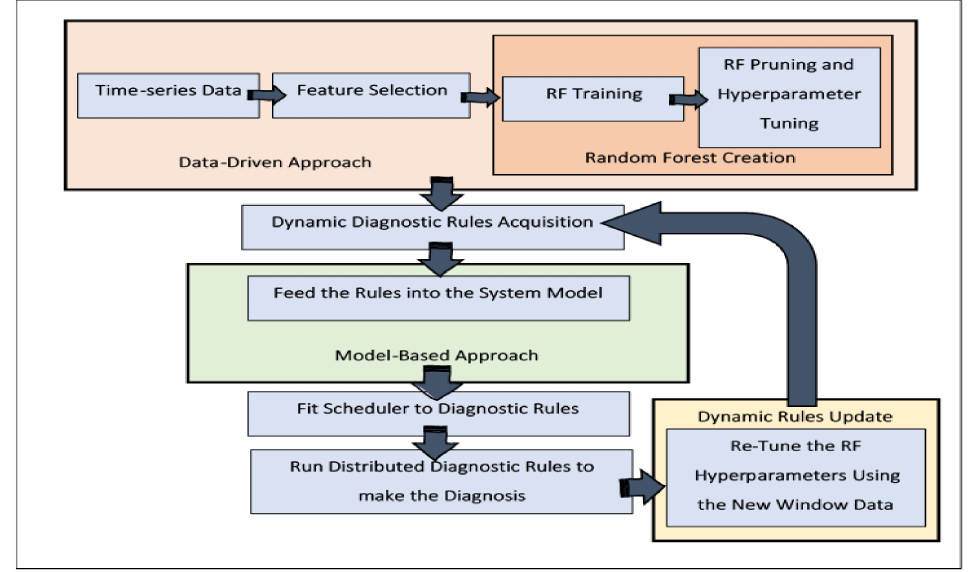
Figure 1. Hybrid-based Fault Detection and Diagnosis System